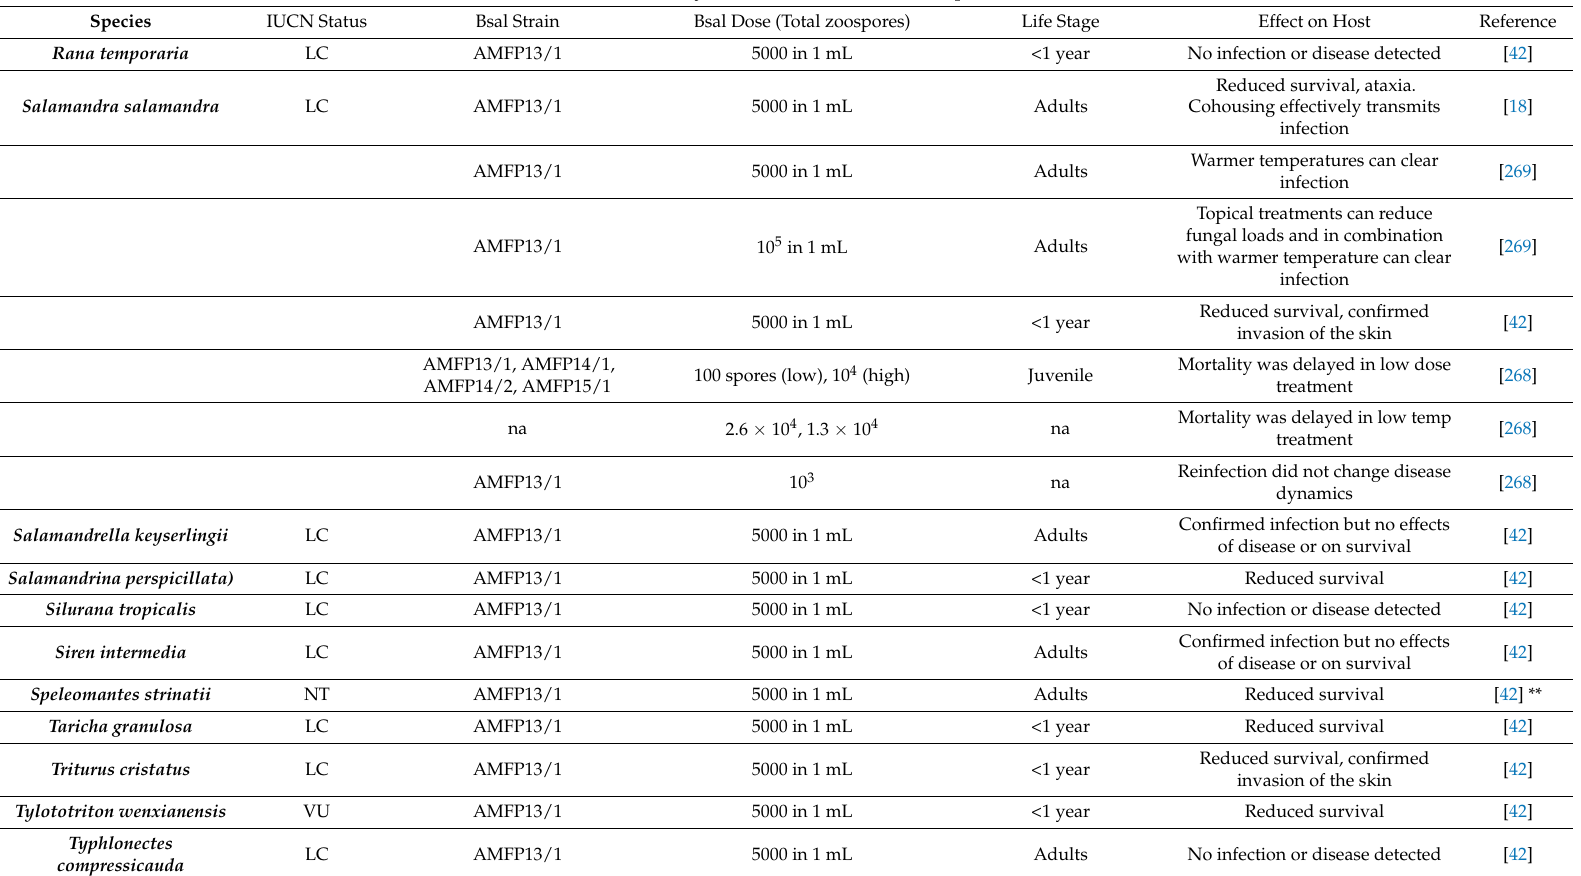
b. Effects of Batrachochytrium salamandrivorans on amphibian